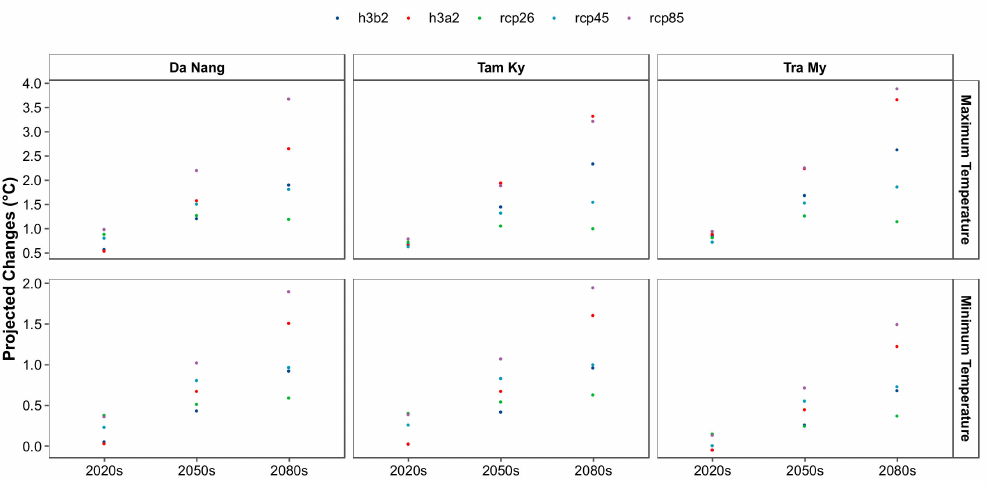
Figure 6. Projected changes in annual average maximum and minimum temperatures in the 2020s, 2050s, and 2080s under scenarios B2, A2 (HadCM3), and RCP2.5, 4.5, 8.5 (CanESM2).